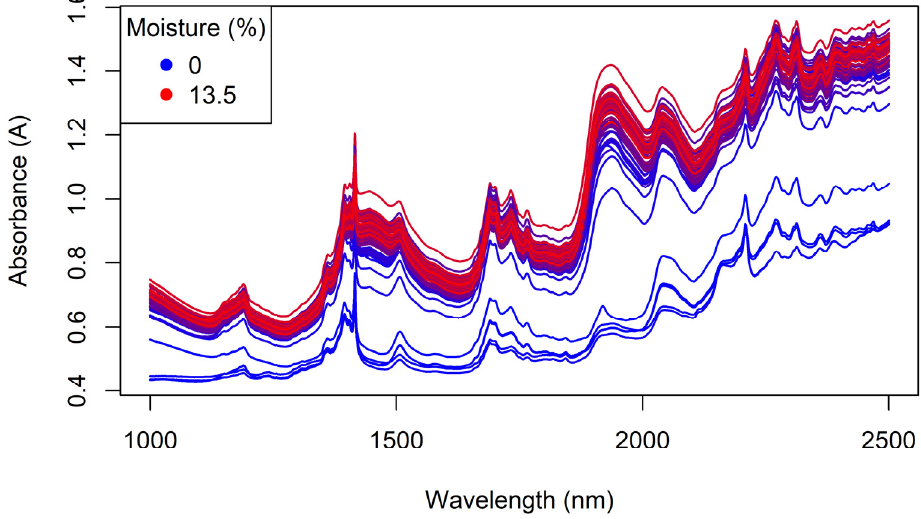
Figure 11. The benchtop NIR spectra of the Regain granules, coloured by moisture content.